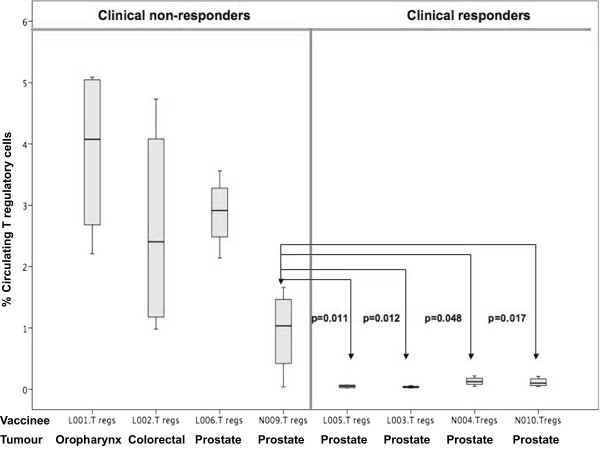
T regulatory cells from 8 vaccinated patients. Four patients experienced partial disease resolution (responders); four had stable or progressive disease during vaccination (non-responders). N009 and N010 were vaccinated with only class I peptide pulsed DCs, whilst L001–L006 were vaccinated with both class I and II peptide-pulsed DCs. Lymphocytes were gated on CD4+ high/side scatter low region which in turn was gated onto CD25 and foxp3, double positive quadrant. Total events acquired were 200,000. Values are represented as median (bar), box (interquartile range) and whiskers (range). The patient with the lowest median T reg value (N009, non-responder) was compared with the T reg values of all the responders and was found to be significantly higher (p < 0.05) using the Mann Whitney-U test. Values are represented as median (IQR) for the duration of the course for each patient. The number of vaccinations varied from 4–21. T reg values were measured at each vaccination time point.